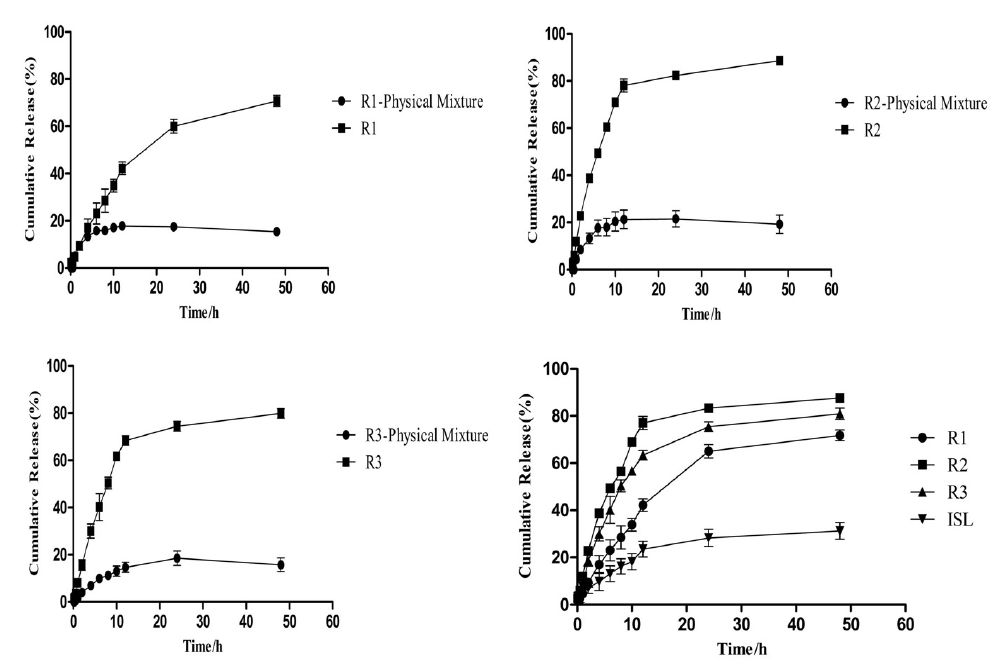
FIGURE 3 - In vitro release curve of the ISL nanocrystal physical mixtures R1 (mPEG2000-PCL1140), R2 (mPEG2000- PCL2000), and R3 (mPEG5000-PCL5000), and the ISL solution in 0.1% SDS (mean ± SD, n =